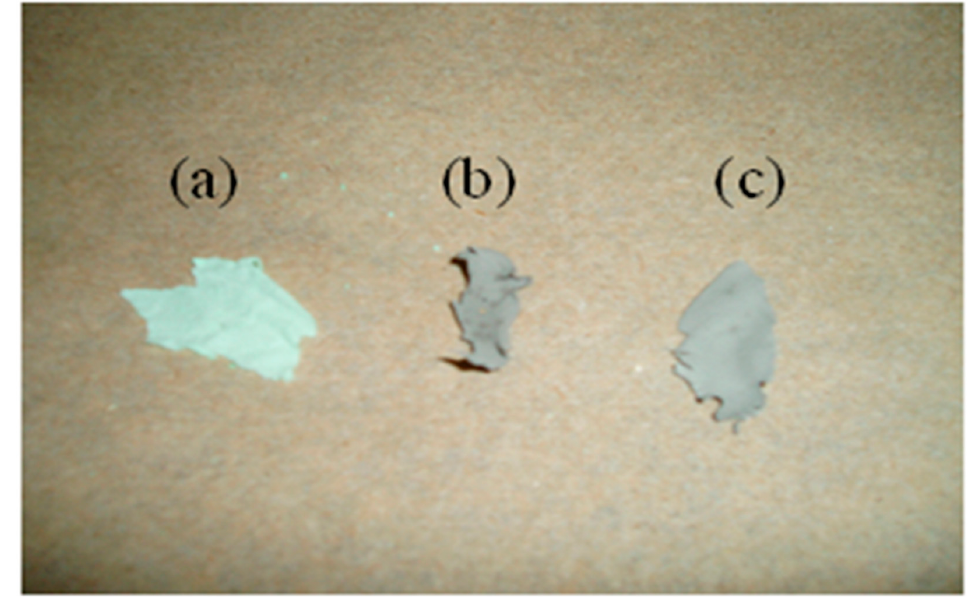
Figure 2. Nanofiber mats for: ( a ) poly(vinyl pyrrolidone) (PVP)/Ni acetate composite, ( b ) NiO after the calcination of PVP/Ni acetate composite at 700 °C, and ( c ) metallic Ni after the reduction of NiO with H 2.